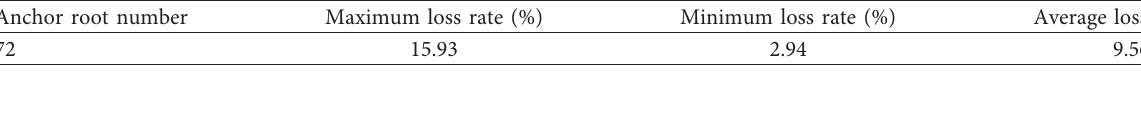
Table 2: 72h loss rate of anchor cable.